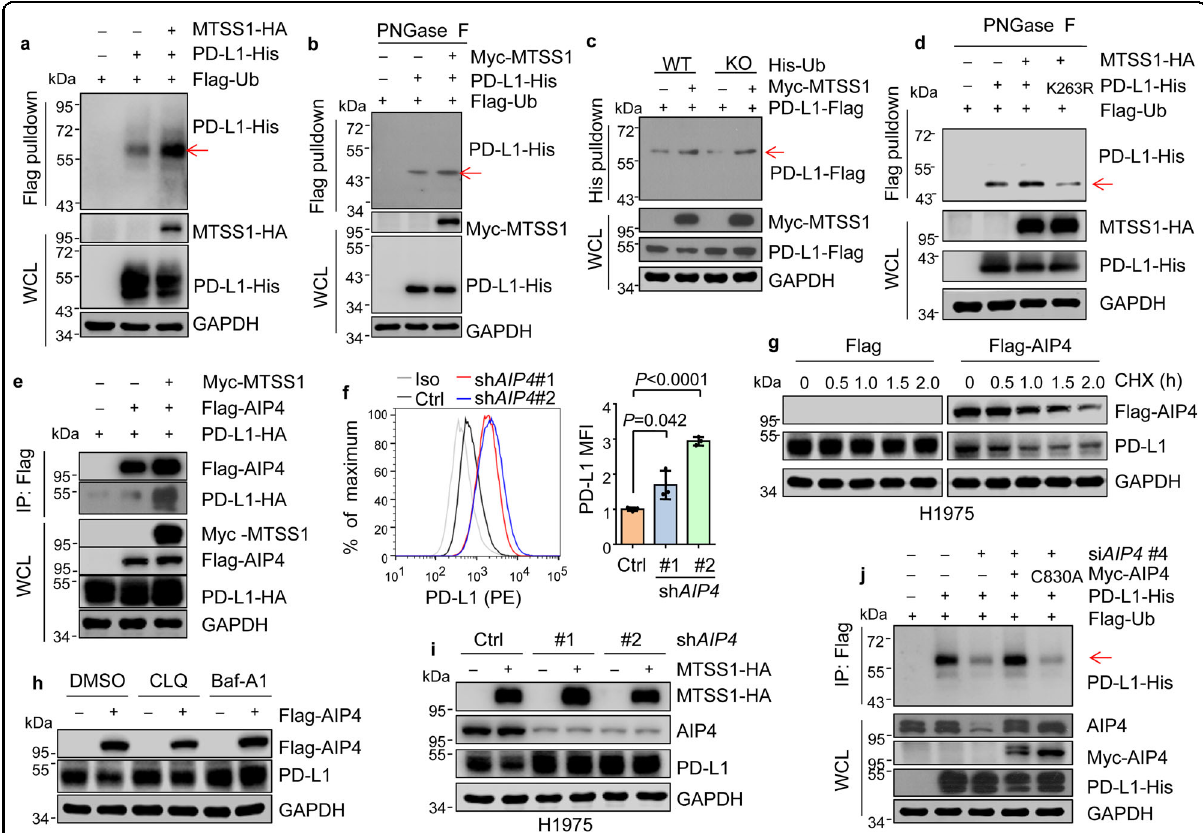
Fig. 4 MTSS1 promotes AIP4-mediated PD-L1 monoubiquitination at K263. a PD-L1 ubiquitination analysis in HeLa cells with or without MTSS1 overexpression. Note that PD-L1 in WCL appeared as multiple bands in 45 – 55 kDa, likely due to glycosylation. b PD-L1 ubiquitination analysis in HeLa cells with in vitro PNGase F treatment of the proteins before immunoblotting. c PD-L1 ubiquitination analysis in HeLa transfected with wild type (WT) or KO mutant ubiquitin (with all seven lysines mutated to arginines), and other indicated constructs. d Ubiquitination analyses of PD-L1 with Lysine 263 mutated to arginine (K263R) in 293 T with in vitro PNGase F treatment of the proteins before immunoblotting. e Co-IP of ectopically expressed AIP4 with PD-L1 in 293 T with or without MTSS1 overexpression. f Flow cytometry analysis of cell surface PD-L1 in 16HBE with AIP4 knockdown. Quantitation of PD-L1 mean fl uorescence intensity (MFI) is shown on the right. Iso, isotype. g , h PD-L1 protein levels in H1975 cells after AIP4 overexpression, with the treatment of cycloheximide (CHX, 100 μ M) for the indicated duration ( g ), or chloroquine (CLQ, 150 μ M) or ba fi lomycin-A1 (Baf-A1, 0.4 μ M) for 12 h ( h ). i PD-L1 protein levels in H1975 with AIP4 knockdown and/or MTSS1 overexpression. j PD-L1 ubiquitination assay in Hela with knockdown of endogenous AIP4 and overexpression of WT or C830A mutant AIP4 . si AIP4 (#4) targets the 3 ’ UTR region of the endogenous AIP4